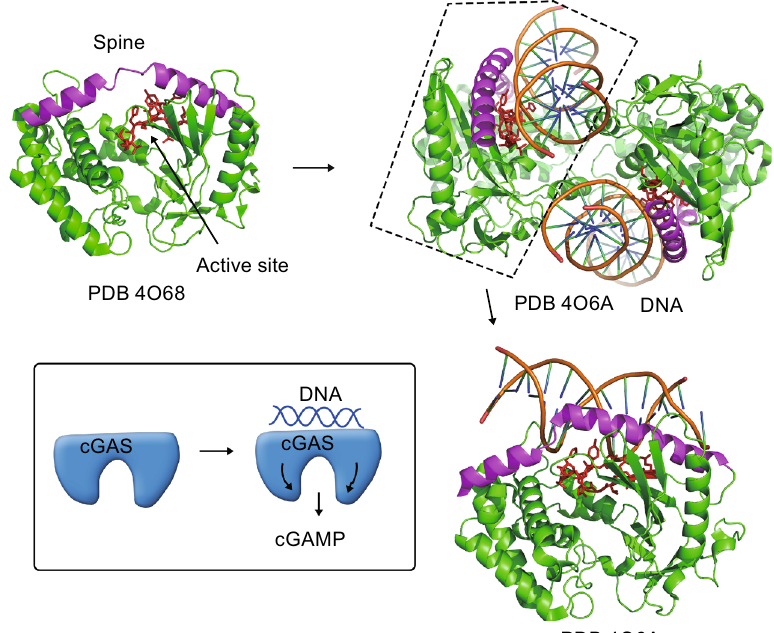
Figure 2. Structural basis of cGAS binding to DNA. In a resting state, cGAS exists with a monomer form. The DNA binding site comprises helices that form a fl at spine. Post DNA binding, cGAS forms dimerization and undergoes conformational changes that render the spine region twisted, promoting synthesis of cGAMP. Inset is an illustration of cGAS activation upon binding